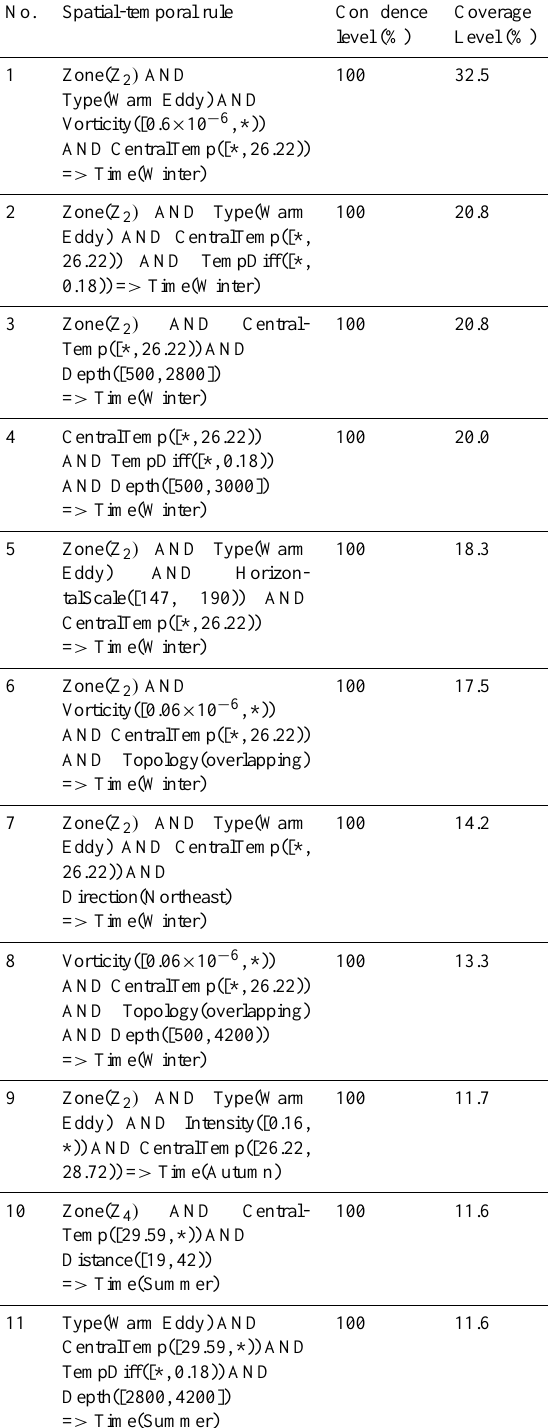
Table 6. Spatial-temporal rules extracted from typical mesoscale- eddy states s in 4